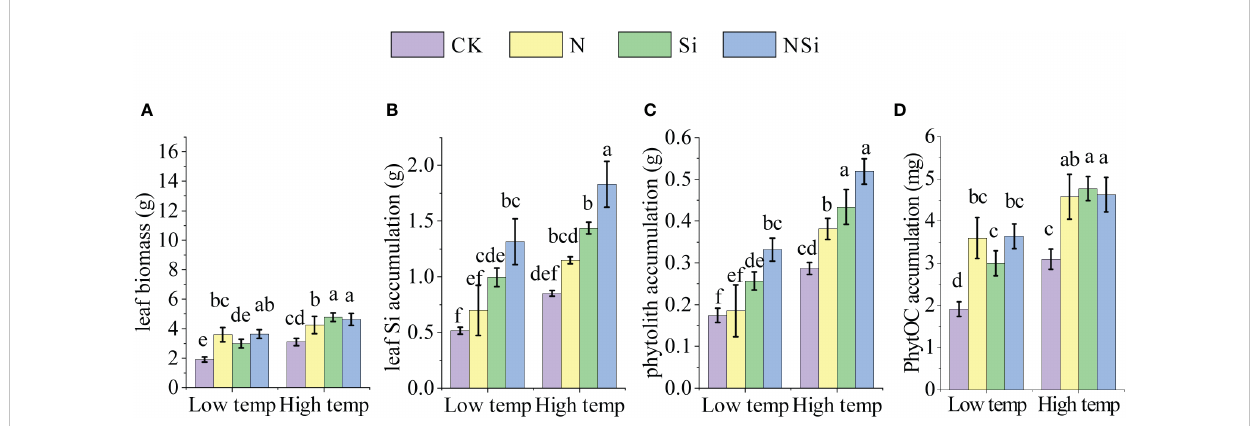
FIGURE 1 The leaf biomass, leaf Si accumulation, phytolith accumulation, and PhytOC accumulation of Moso bamboo leaves at low- and high temperature with different fertilization. (A) leaf Si biomass, (B) leaf Si accumulation, (C) phytolith accumulation, and (D) PhytOC accumulation. CK, N, Si, and NSi represent the level of fertilization at 0N 0Si kg/hm 2 , N157.5 kg/hm 2 , Si 315 kg/hm 2 , N157.5 kg/hm 2 and Si 315 kg/hm 2 , respectively. Error bars represent the standard error of the means. Different letters indicate signi fi cant differences among the treatments of different fertilization at 0.05 level,